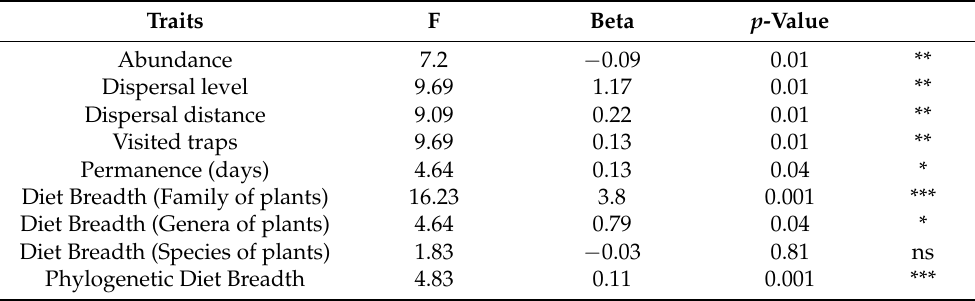
Visited traps Diet Breadth (Family of plants) 16.23 Diet Breadth (Genera of plants) Diet Breadth (Species of plants) Phylogenetic Diet